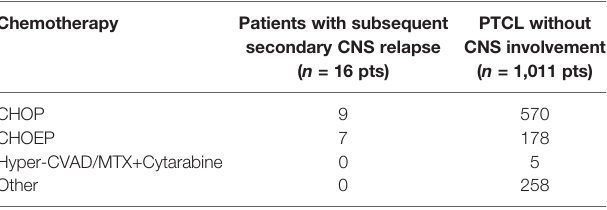
TABLE 3 | First-line treatment in patients with peripheral T-cell lymphomas without initial CNS involvement ( n =